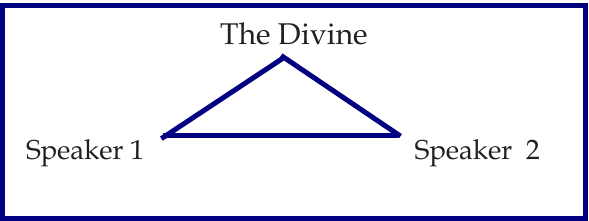
Figure2: Multiparty Interaction Including the Divine In this way, the divine is brought into the room as a relevant participant in the interaction.